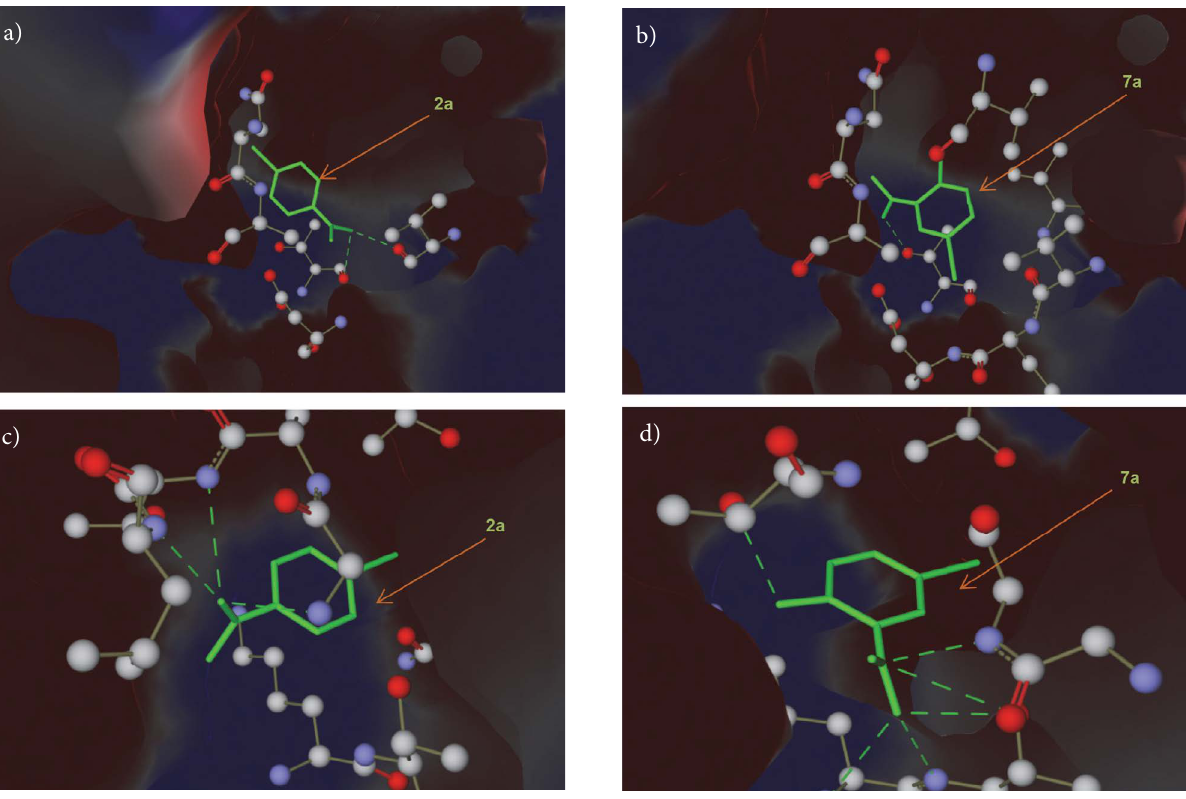
Figure 1. Molecular interaction of the compounds 2a and 7a at the active pockets of the protein 1KZN (a and b) and 3SRW(c and d) (green dotted lines indicate the mode of interaction with the